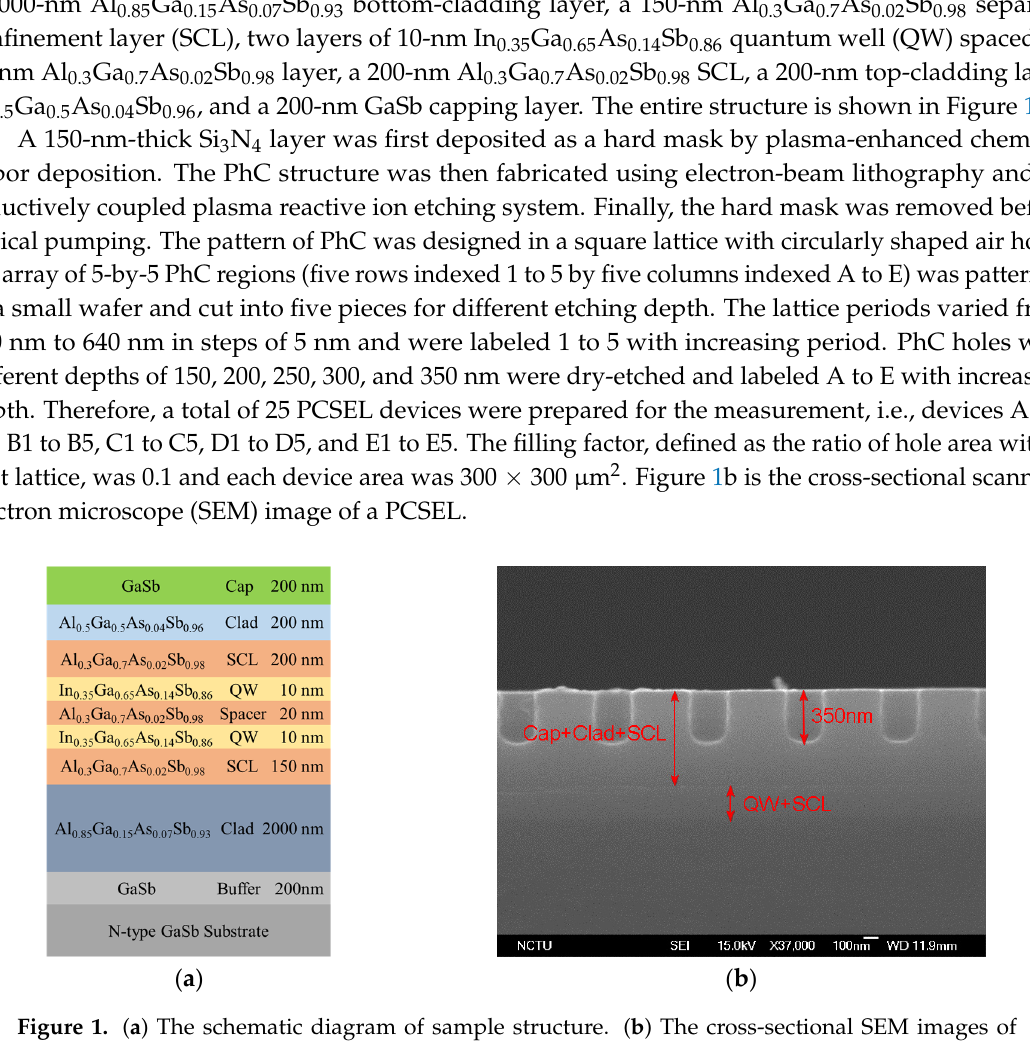
Figure 1. ( a ) The schematic diagram of sample structure. ( b ) The cross-sectional SEM images of a PCSEL. a